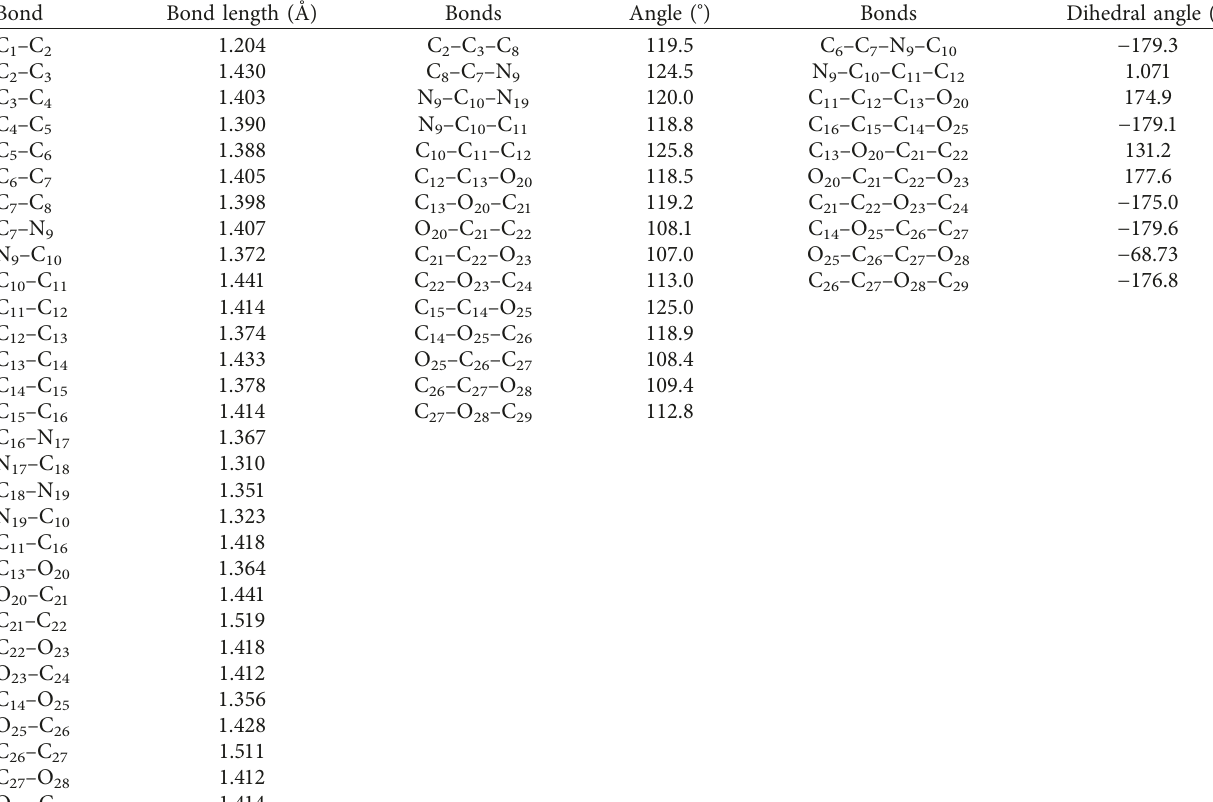
Table 1: The selected calculated bond lengths and angles of